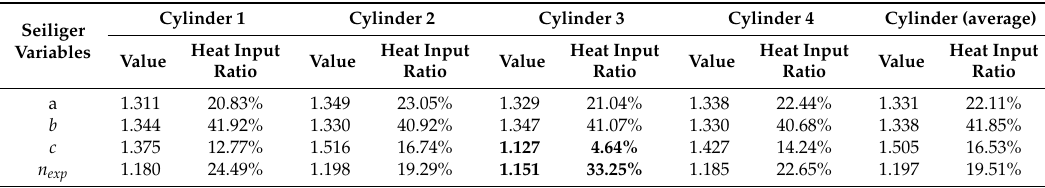
Table 6. Results of advanced Seiliger process fit in 4 cylinders.